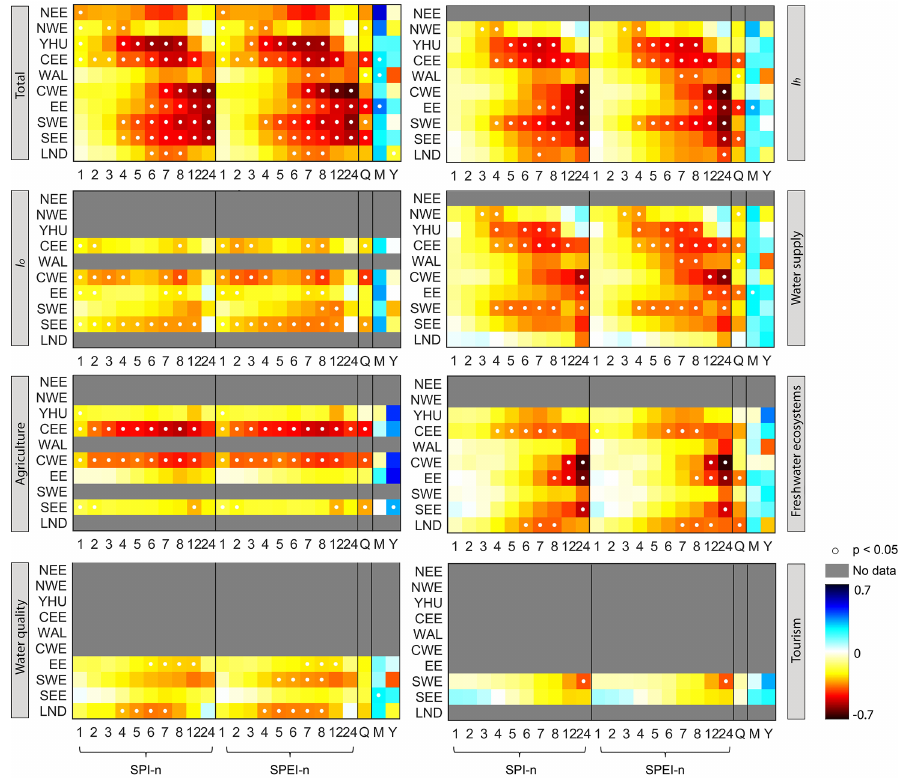
Figure 3. UK: rank correlation coefficients ( ρ ) between drought indicators and number of impact occurrences for total impacts, hydrological drought impacts ( I h ), impacts due to other types of drought ( I o ), and selected impact categories per NUTS1 region.